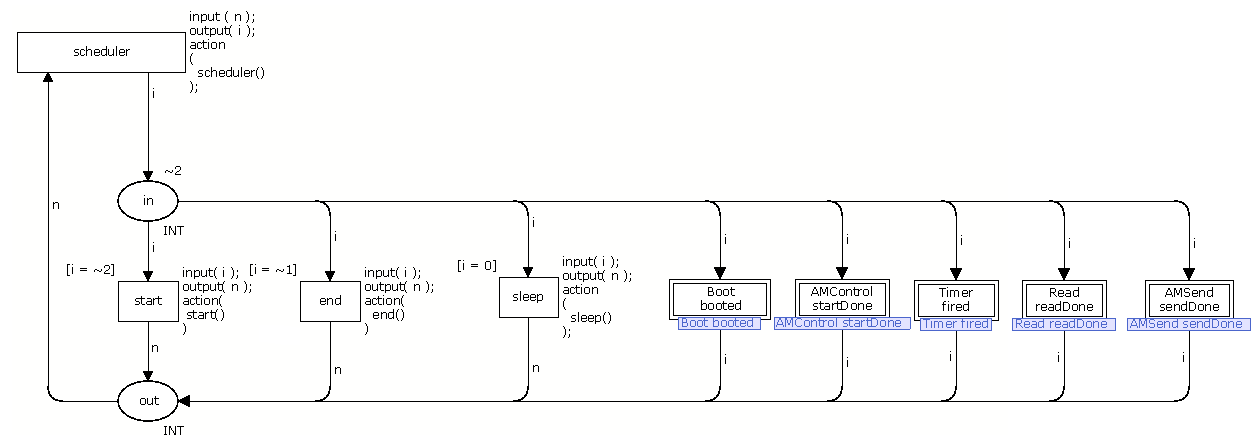
Figure 17. module scheduler of App5 .